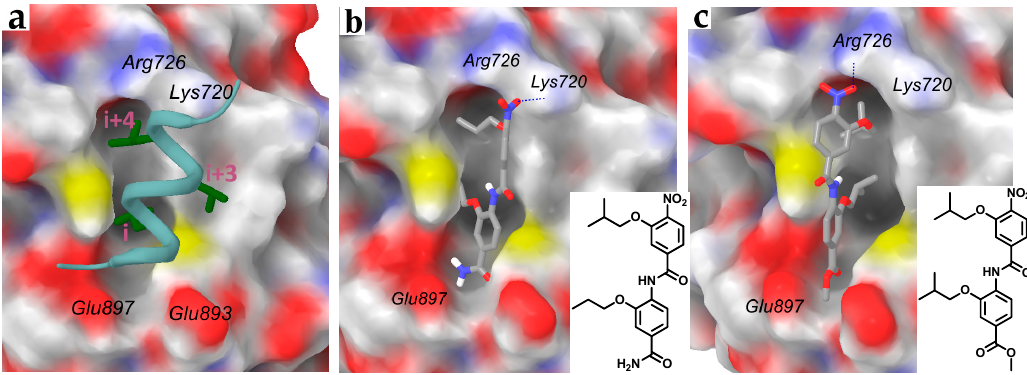
Figure 5. Molecular docking studies of 14d on the AF-2 domain of AR. ( a ) Crystal structure (PDB code 1T63) of the LXXLL motif bound on the AF-2 domain. ( b ) Predicted binding mode of 14d . ( c ) Predicted binding mode of D2 .